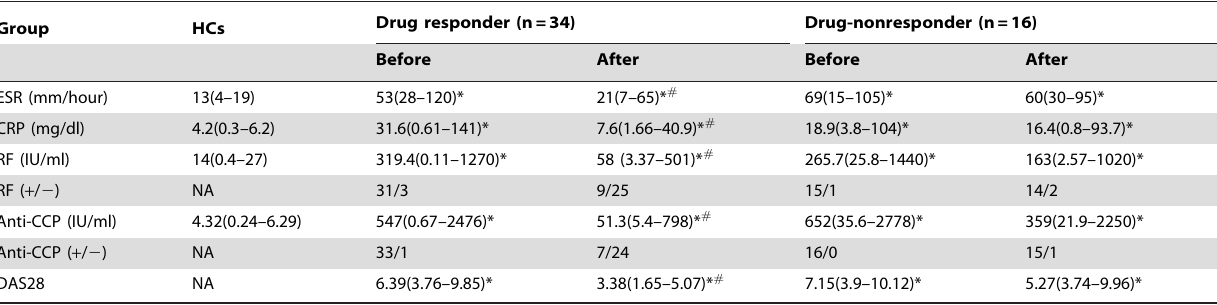
Table 1. Demographic and clinical characteristics of